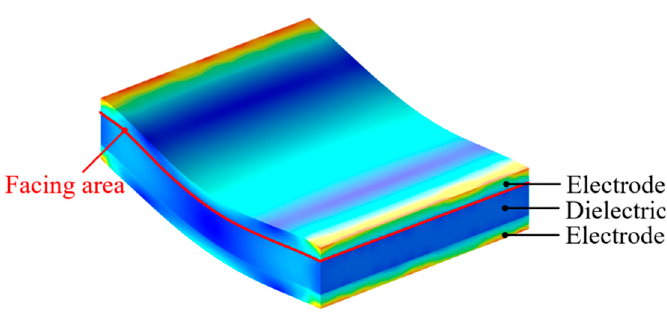
Figure 5. Diagram of the facing area increase during impact.